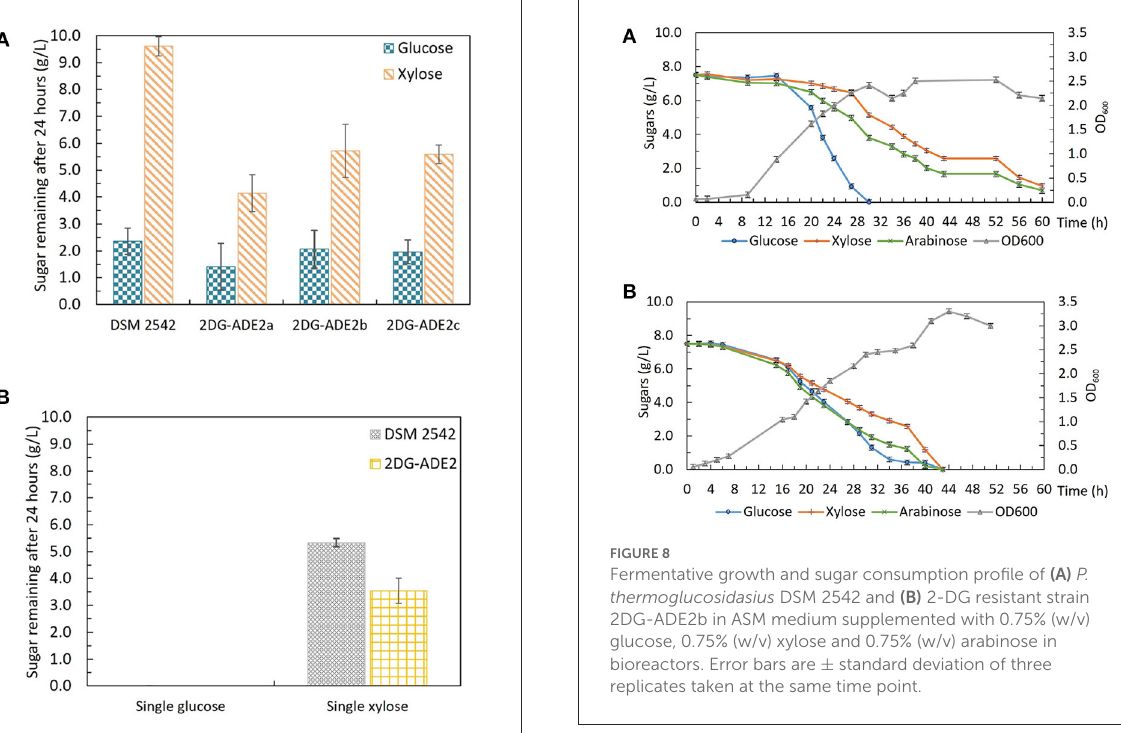
FIGURE7 Sugar consumption profiles of P. thermoglucosidasius DSM 2542 and 2-DG resistant strains 2DG-ADE2a, 2DG-ADE2b and 2DG-ADE2c during tube fermentation in 15 mL sterile centrifuge tubes. Cells were cultured in ASM medium supplemented with (A) 1% (w/v) glucose and 1% (w/v) xylose or (B) 1% (w/v) glucose or 1% (w/v) xylose. To stabilize the pH during the fermentation, 0.2 g MgCO 3 was added to the tubes prior to inoculation. Error bars in (A,B) DSM 2542 are ± standard deviation of three replicates taken at the same time point. Error bars in (B) 2DG-ADE2 are ± standard deviation of 2DG-ADE2a, 2DG-ADE2b, and 2DG-ADE2c samples (three replicates) taken at the same time point. A t -test performed on data in (A) confirmed the remaining glucose and xylose in each strain were statistically different ( p < 0.05).